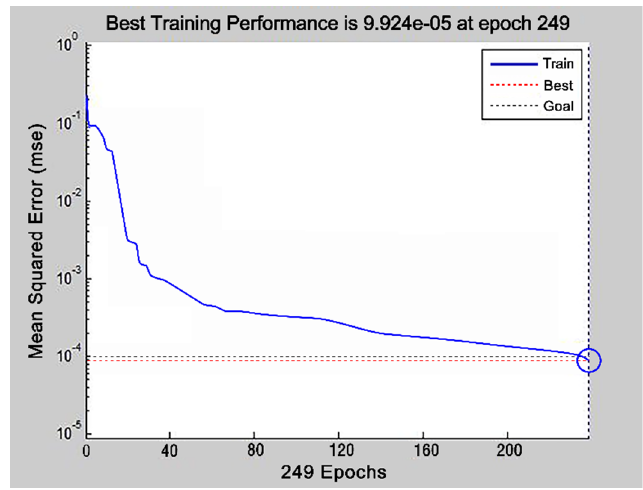
Figure 13. Training error curve.